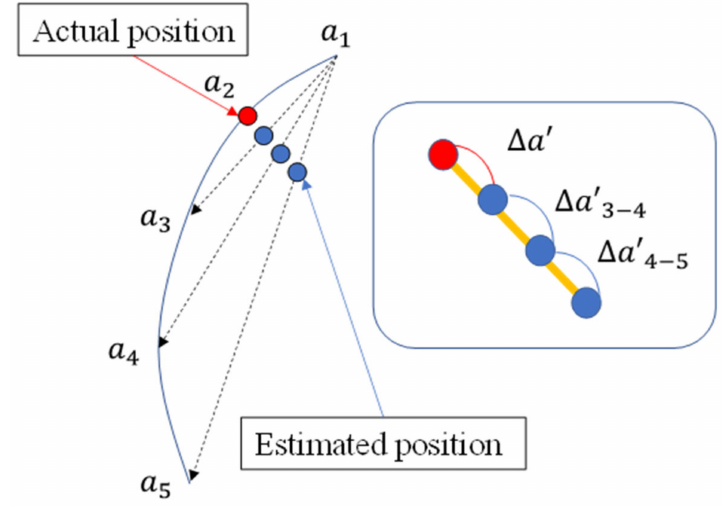
Figure 8. Overview of the method used to calculate the position estimates in this study.